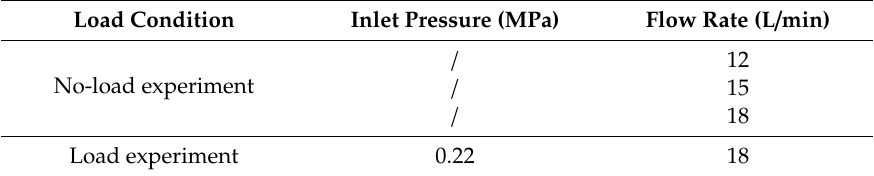
Table 5. Experiments for testing the control accuracy of the motion.